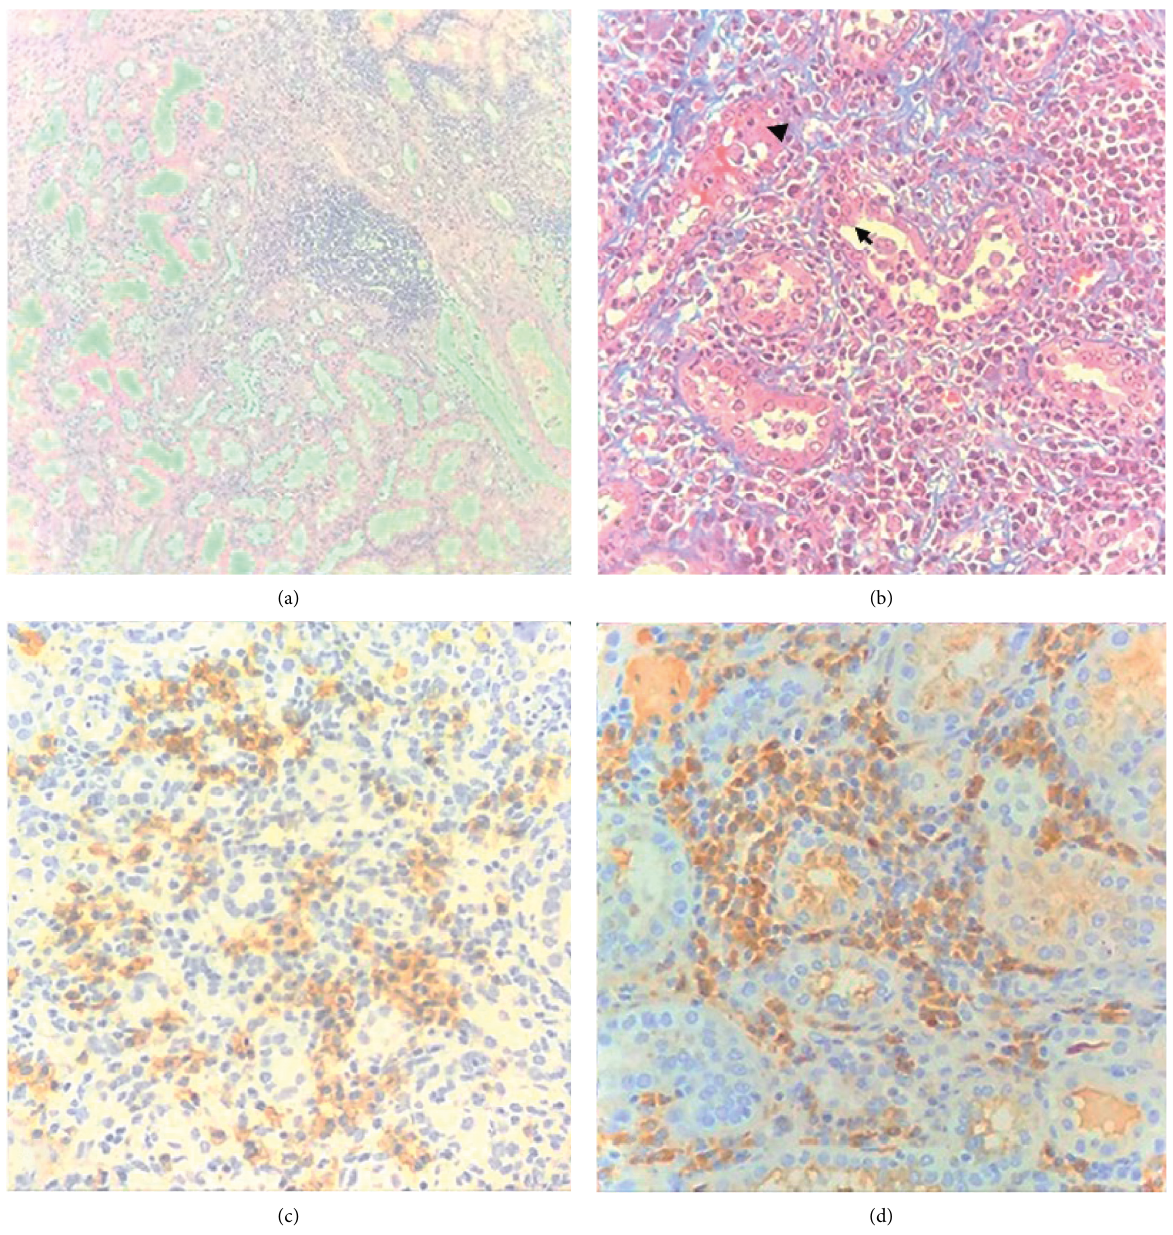
Figure 2: Renal biopsy immunohistochemistry. (a) In the microphotograph with HyE, we can observe part of the medulla composed by tubules with acute tubular necrosis and disappearance of nuclei in a few cells. The interstitium is altered by the presence of the chronic lymphoplasmacytic infiltrate, arranged by cumulus in some areas, but also the presence of slight fibrosis. (b) Masson staining shows interstitial thickening secondary to the lymphoplasmacytic infiltrate reaching the proximal contoured tubules giving an irregularity in its contour. As a paramount feature, the presence of eosinophilic inclusions (arrowhead) in the cytoplasm of the epithelium covering these tubules is seen and also the desquamation of this epithelium which is compatible with LCPT (arrow). Blue staining confirms the presence of slight fibrosis. (c) Immunohistochemical staining for CD138 (plasma cell biomarker) was performed with a significant reaction at the membrane level highlighting the abundant presence of plasma cells. (d) Reaction to kappa light chains (brown staining) shows variable positivity inside the cytoplasm of plasma cells at the interstitium, which represents its